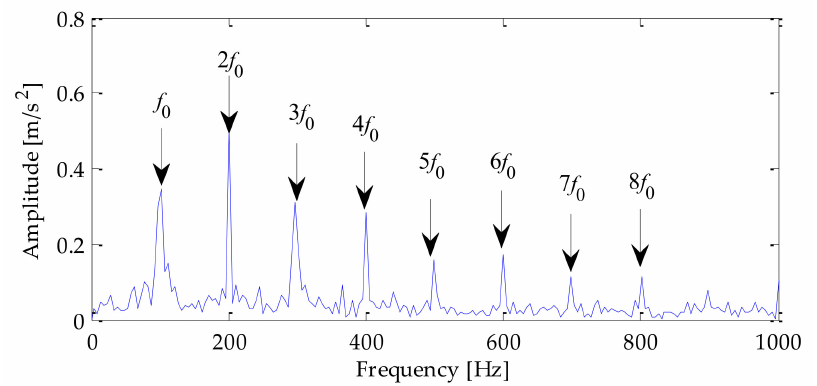
Figure 16. Analysis of signal envelope spectrum after noise reduction based on the proposed method.